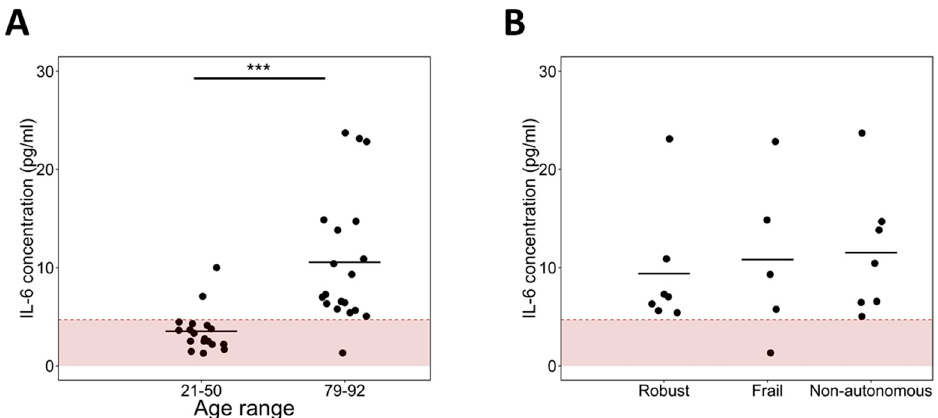
Figure 1. An elevated concentration of interleukin-6 (IL-6) is observed in aged subjects. IL-6 levels were measured by ELISA and concentration values above 4.7 pg/mL were considered detectable. ( A ) Elderly individuals have a higher concentration of IL-6 than adults (*** p < 0.001); and ( B ) there is a high variability among Robust, Frail and Non-autonomous elderly, but an increasing concentration with dependency can be observed. Each dot shows the concentration of a subject and the line represents the average value of the group.